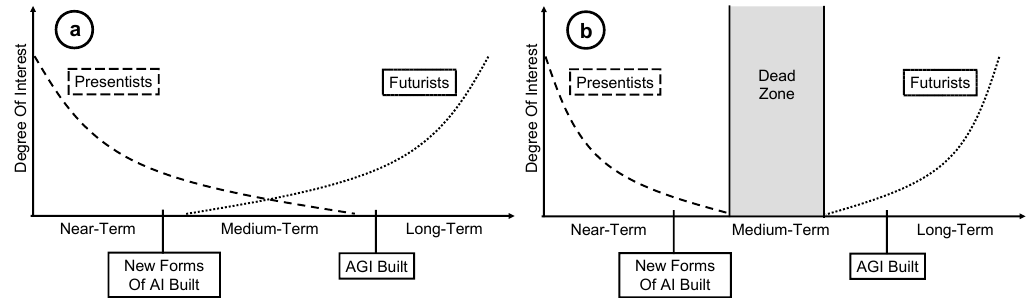
Figure 2. Illustrative sketches of presentist and futurist interest in the near, medium, and long term. ( a ) shows overlapping interest: the medium-term AI hypothesis holds; ( b ) shows a dead zone with no overlapping interest: the medium-term AI hypothesis does not hold. The sketches are strictly for illustrative purposes only. The phrase “new forms of AI built” is defined with reference to the definition of near-term AI in the main